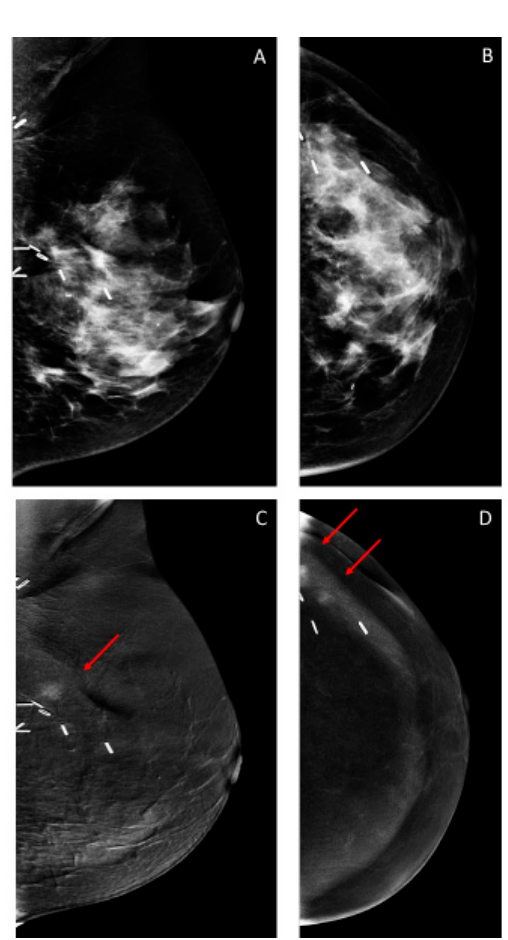
Figure 2. Forty-nine-year-old woman treated with left breast conservation surgery 3 years prior for unifocal invasive ductal carcinoma (IDC) and ductal carcinoma in situ (DCIS). ( A , B ) No suspicious findings on low-energy images. ( C , D ) Iodine images show two sub-centimeter areas of non-mass enhancement immediately superior and lateral to the surgical clips at the lumpectomy bed (arrows); one lesion is obscured on the mediolateral oblique (MLO) view by an overlying surgical clip. Two sonographic correlates were identified and biopsied, both yielding IDC. The patient was then treated with a mastectomy.